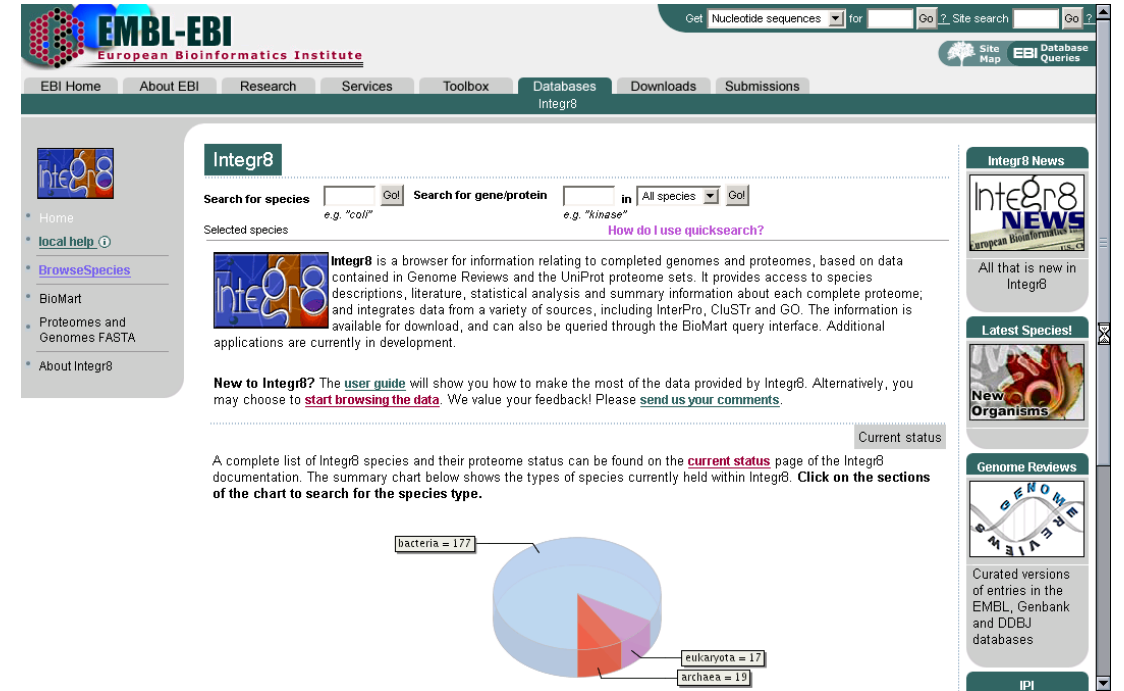
Figure 1: The Integr8 entrance page - users can search for species, genes or proteins, and get further information on whole proteomes and